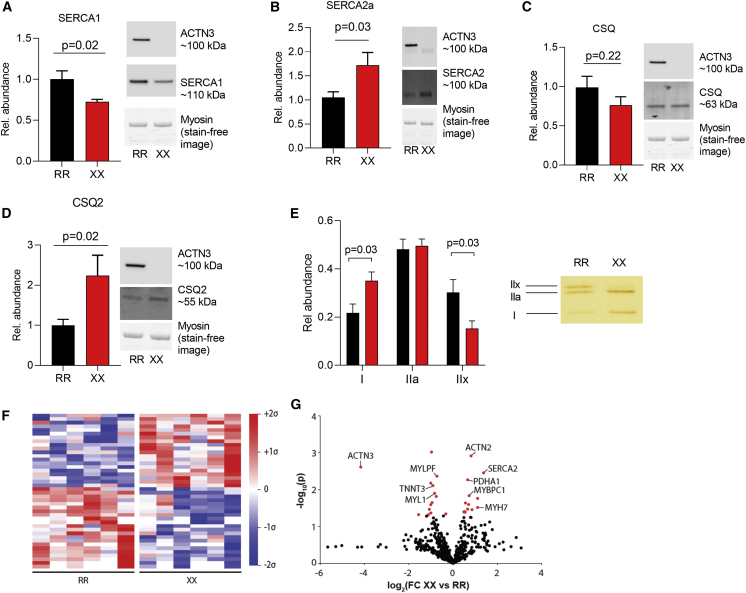
ACTN3 deficiency is accompanied by a shift toward a slower skeletal muscle phenotype(A–D) Summary data (mean ± SEM) and representative western blots of the SR Ca2+-handling proteins SERCA1, SERCA2a, CSQ, and CSQ2 in muscle of RR (n = 8) and XX (n = 7) individuals. Band intensities were normalized to their respective myosin loading controls. Data expressed relative to the mean value of the RR group, which was set to 1.0. Statistical difference between the two groups was assessed with unpaired t test.(E) Silver-stained gels were used to assess the distribution of MyHC isoforms in RR (n = 7) and XX (n = 7) individuals. Right part shows a representative example of the distribution of MyHC in RR and XX individuals. The total staining of the three MyHC bands was set to 1 in each subject. Statistical difference between the two groups was tested with unpaired t test.(F) Mean-centered sigma-normalized heatmap of differentially expressed proteins (p < 0.05).(G) Volcano plot of all identified proteins (n = 601) expressed as fold-change (FC) in XX compared to RR individuals. Differentially abundant proteins are indicated in red.